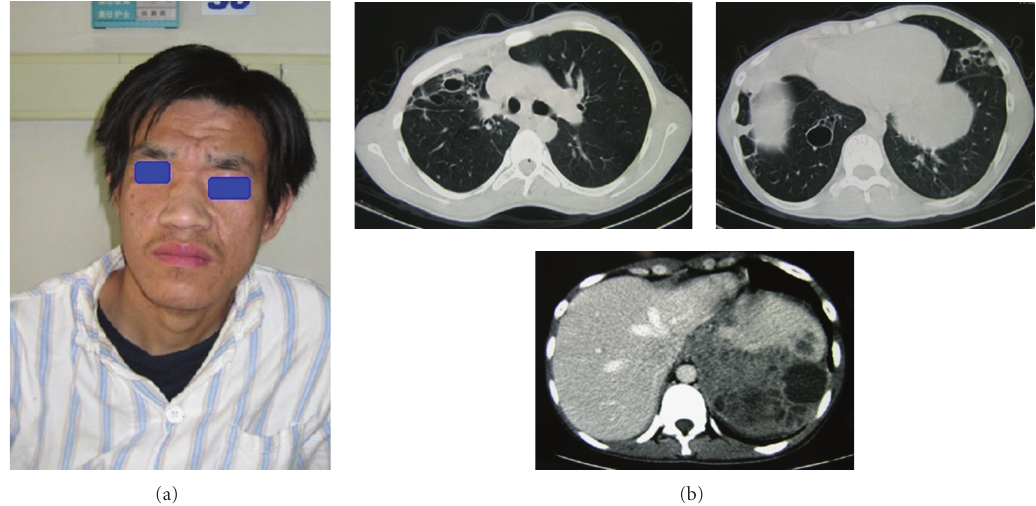
Figure 1: Symptoms. (a) The patient with broad nose, deep-set-eyes, a prominent forehead, and a rough facial skin with exaggerated pore size. (b) Multiple cysts in the left upper